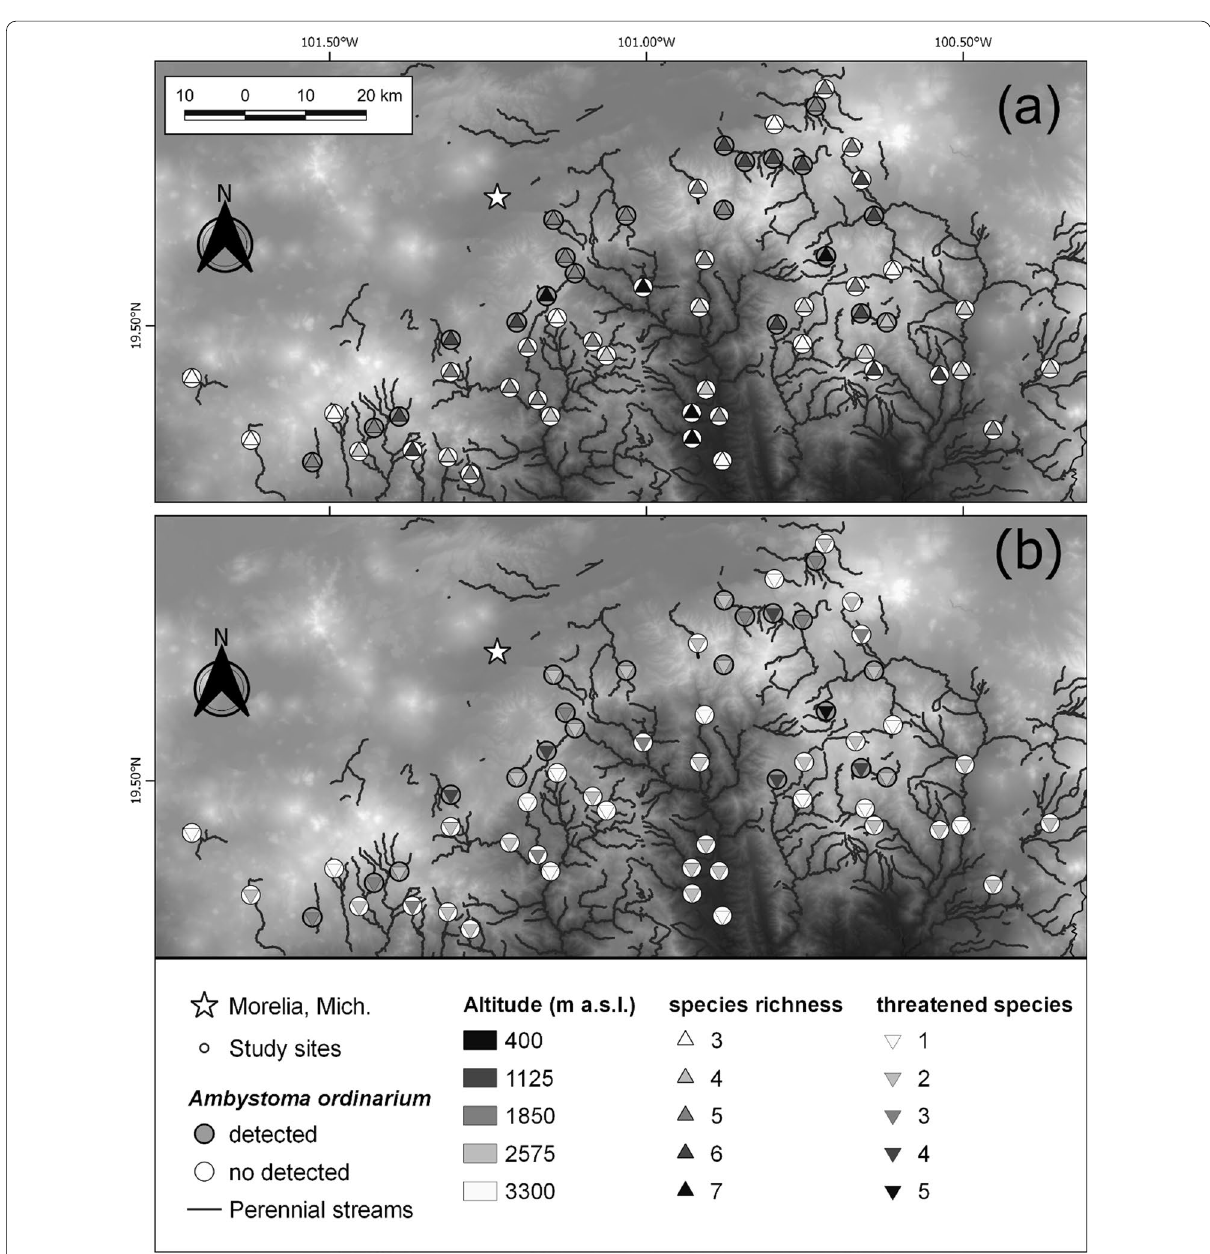
Fig. 4 Estimated values for a species richness and b number of threatened species for each sampling